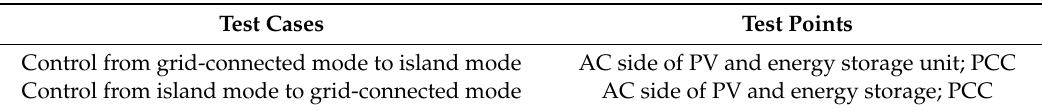
Table 3. Grid-connection/island switching test of the microgrid.